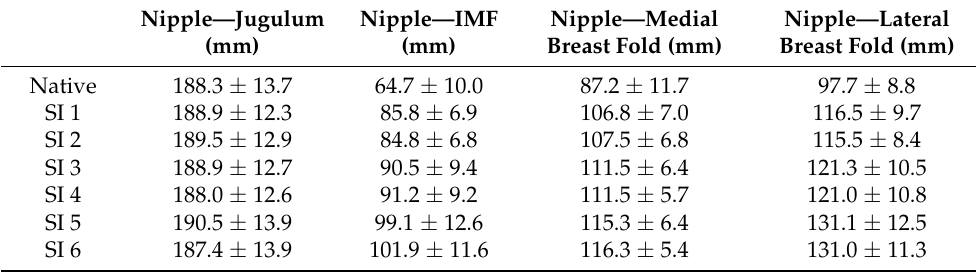
Figure 4. Estimated mean TS for each breast quadrant dependent on implant size. Quadrant I = superolateral, quadrant II = superomedial, quadrant III = inferomedial and quadrant IV = inferolateral breast quadrant. In quadrant I, II, and III the increase of the TS correlated with the implant size (round and anatomical shape). In quadrant IV, no significant difference in TS was observed when comparing between implant sizes. Table 4. Inter-landmark distances. Nipple—jugulum, nipple—inframammary fold (IMF), nipple— medial breast fold and nipple—lateral breast fold distances are presented for each study implant (SI). Data are presented as mean ± standard